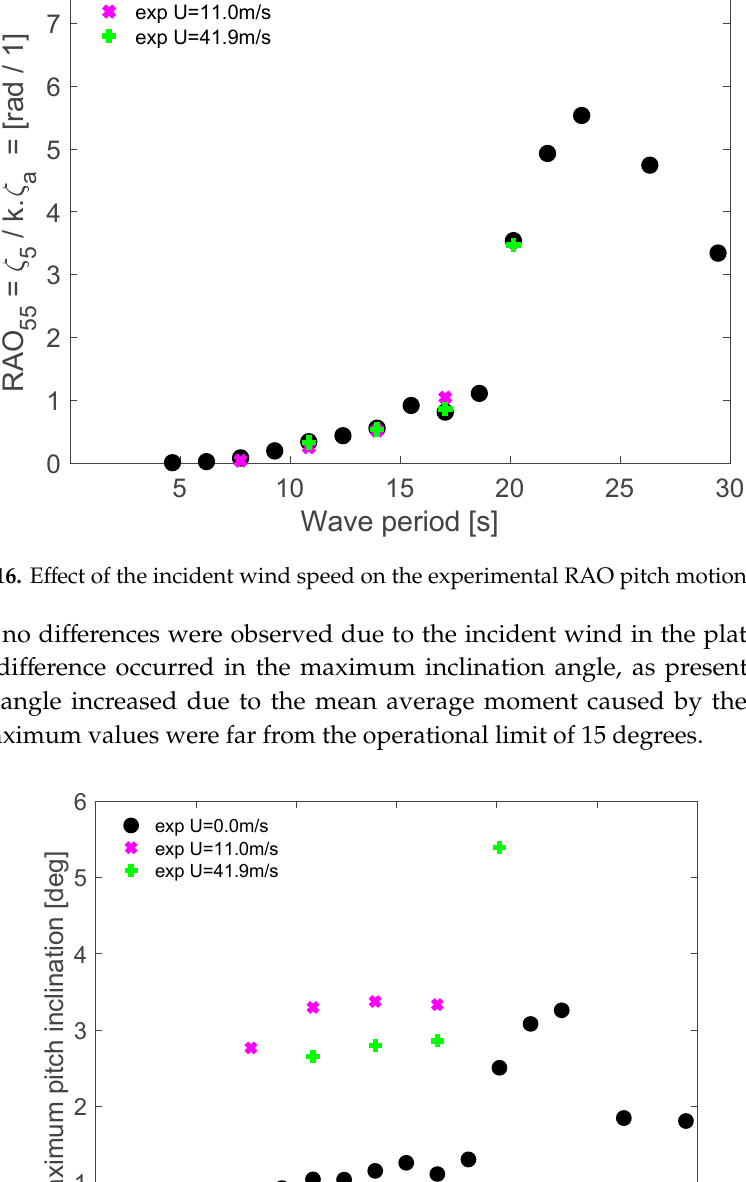
Figure 15. Effect of the incident wind speed on the experimental RAO heave motion results.